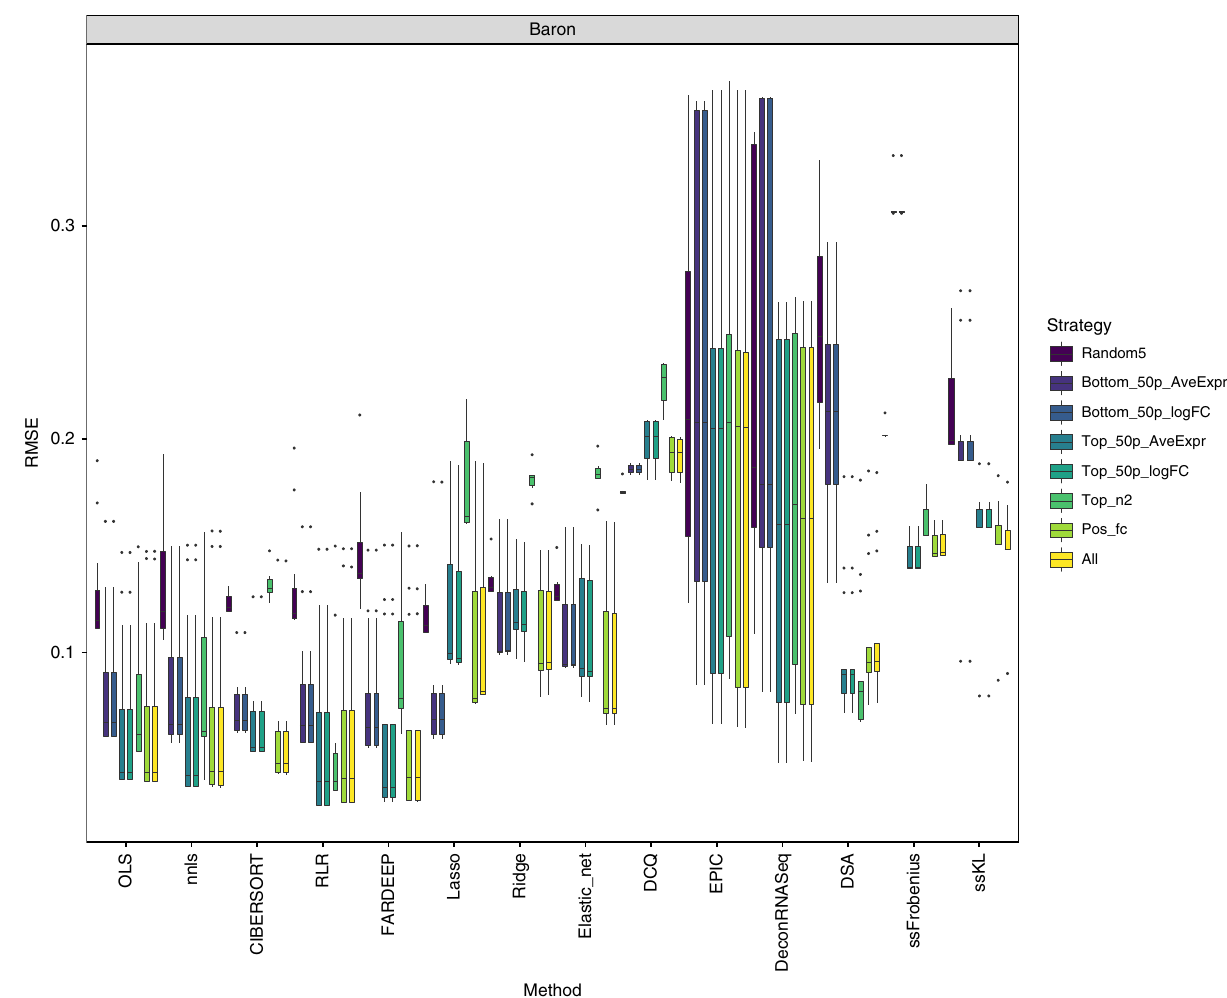
Fig. 4 Impact of the marker selection on the deconvolution results. RMSE values between the expected (known) proportions in 1000 pseudo-bulk tissue mixtures (linear scale; pool size = 100 cells per mixture) and the output proportions from the Baron dataset, using eight different marker selection strategies. Each boxplot contains all normalization strategies that were tested in combination with a given marker strategy across the different bulk deconvolution